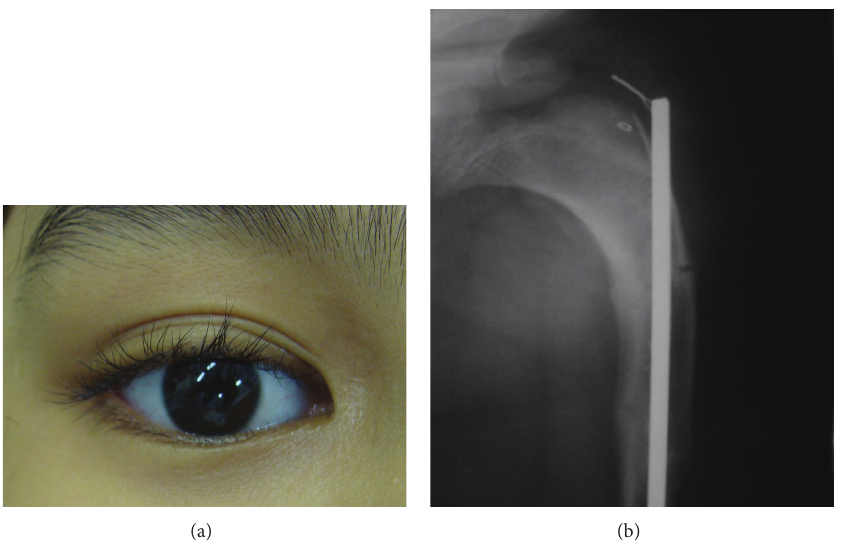
Figure 1: Detail of the blue sclera, a common clinical finding in type IV osteogenesis imperfecta (a), and deformed limbs with arched appearance with medical history of bone fractures (b).